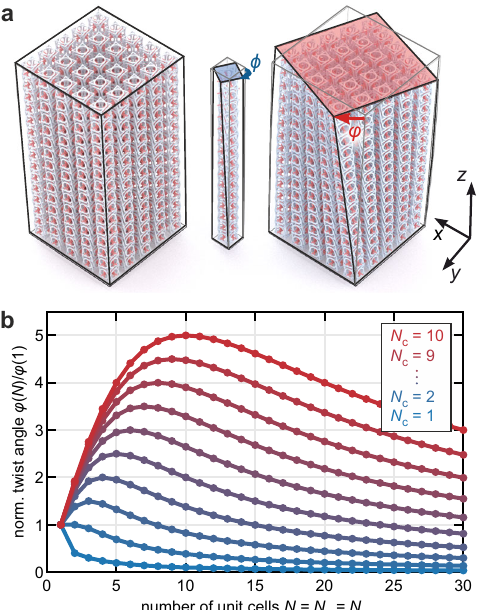
Fig. 2 Illustration of the simple analytical model. a Crystal lattices composed of N x × N y × N z = 5 × 5 × 15 (left and right) and 1 × 1 × 15 (center) unit cells of the type shown in Fig. 1. Under compressive loading, the 1 × 1× 15 column twists by the indicated angle ϕ = φ (1, 15) < 0. The metamaterial crystal to the right twists under compressive loading by the indicated mean angle φ = φ (5) = φ (5, 15) < 0, which is generally different from ϕ . The difference of the two angles, mediated by the red connector arms (also see Fig. 1), leads to an important contribution to the total linear-elastic energy within the simple model. b Calculated twist angles φ ( N ) = φ ( N , 3 N ) from our simple analytical model versus integer values of N (dots) for different characteristic numbers N c = 1, 2, … 10 (see legend). The straight lines between dots are merely guides to the eye. For N c > 1, φ ( N ) / φ (1) monotonously increases as a function of N and reaches its maximum at N c . For N > N c , the twist angle approaches an ∝ 1/ N